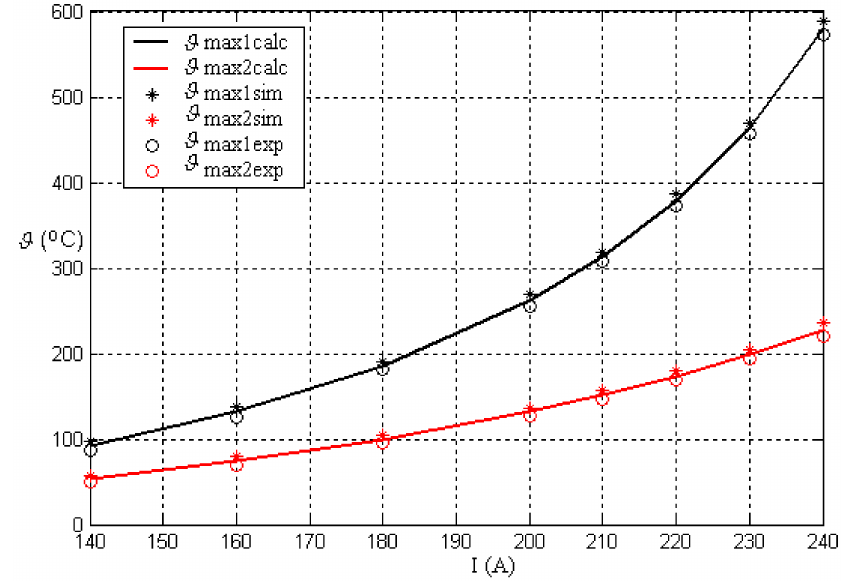
Figure 11. Maximum temperature rise variation at different current values. Comparison between computed ( ϑ max 1 calc , ϑ max 2 calc ), simulated ( ϑ max 1 sim , ϑ max 2 sim ) and experimental results ( ϑ max 1 exp , ϑ max 2 exp